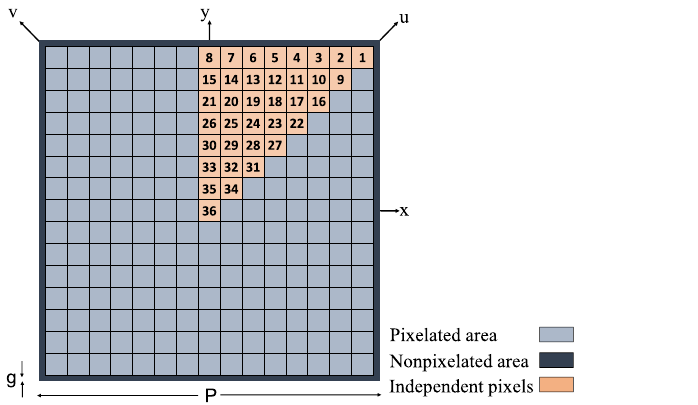
Figure 3. Schematic of the pixelated FSS unit cell.